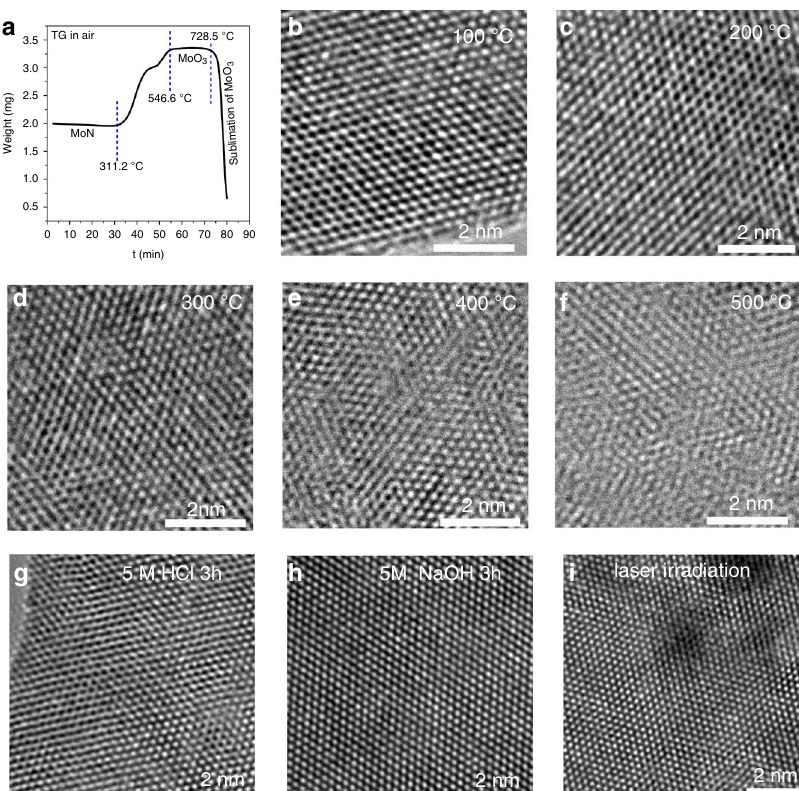
Fig. 5 Thermal, chemical, and light stability of the δ − MoN nanosheets. a TG curve. b – f HRTEM images recorded from the nanosheets treated at different temperatures. g – i HRTEM images of the δ − MoN nanosheets treated with HCl, NaOH, and laser irradiation.